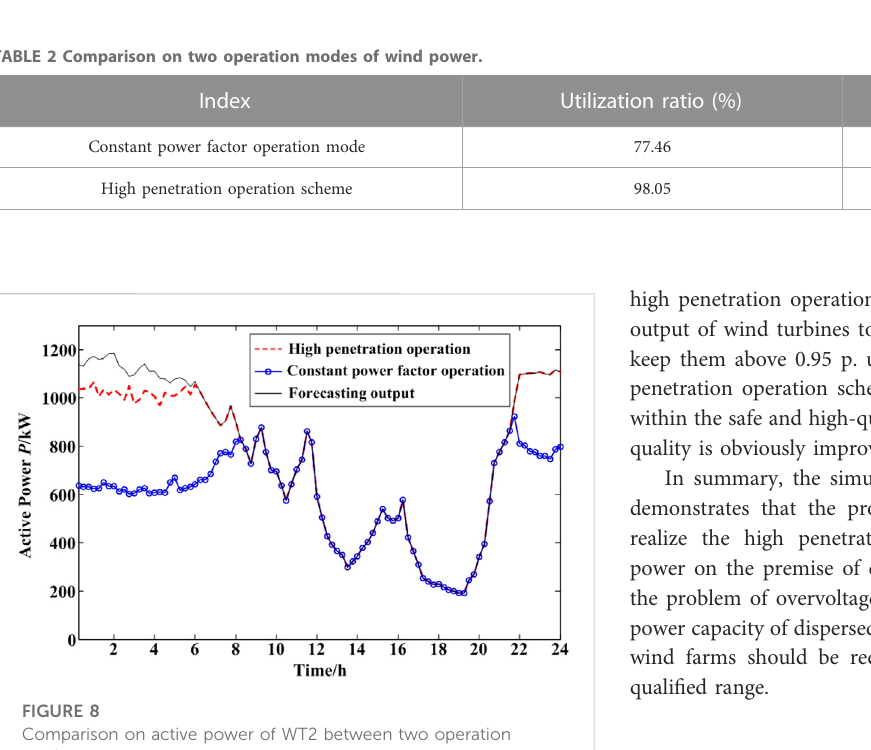
Figure 9B, the capacity of reactive power is limited, so the active adjust the voltage to the de fi ned scope. 2) During 5 p.m. – 8 p.m., in